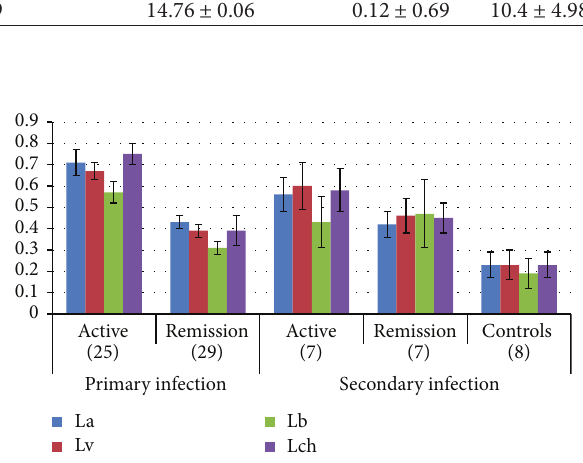
Figure 1: ELISA with monovalent amastigotes antigens, sera from patients with active cutaneous leishmaniasis and postspontaneous remission of lesions in primary or secondary infections as com- pared to sera from controls (patients). La: L(L)amazonensis ; Lv: L(L)venezuelensis ; Lb: L(V)brasiliensis ; Lch: L(L)chagasi.